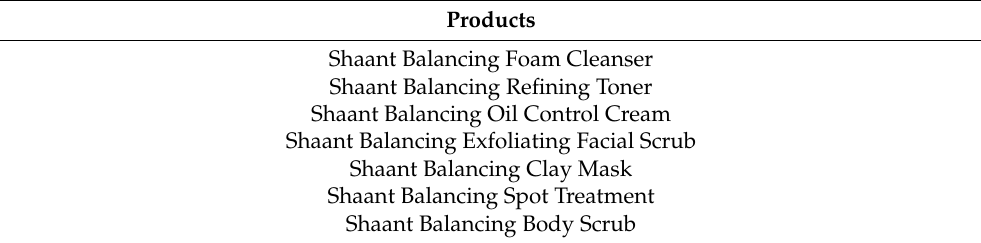
Table 1. Products